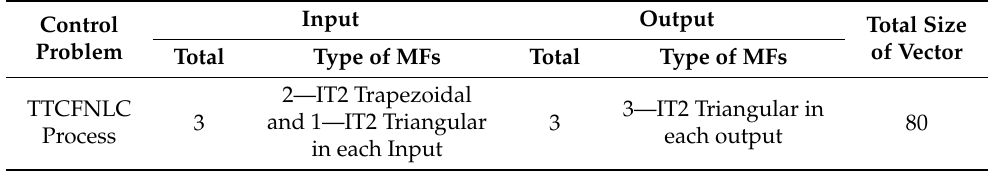
Table 1. Size of vector in the optimization by fuzzy CS and FP algorithm for control